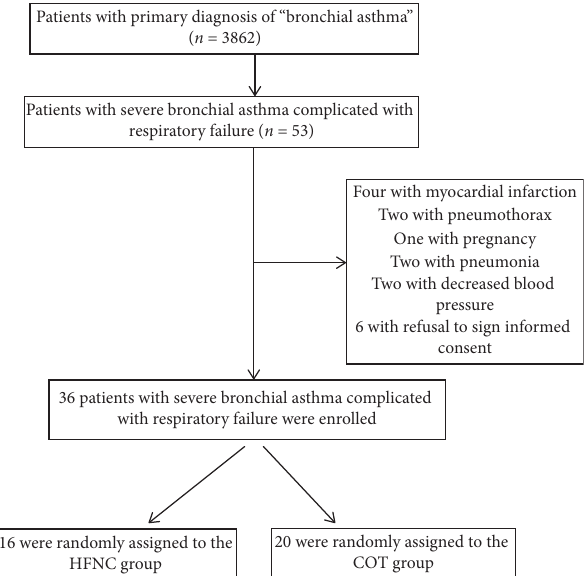
Figure 1: Flowchart of the patient selection process. Table 1: Baseline characteristics of patients in the HFNC and COT groups.